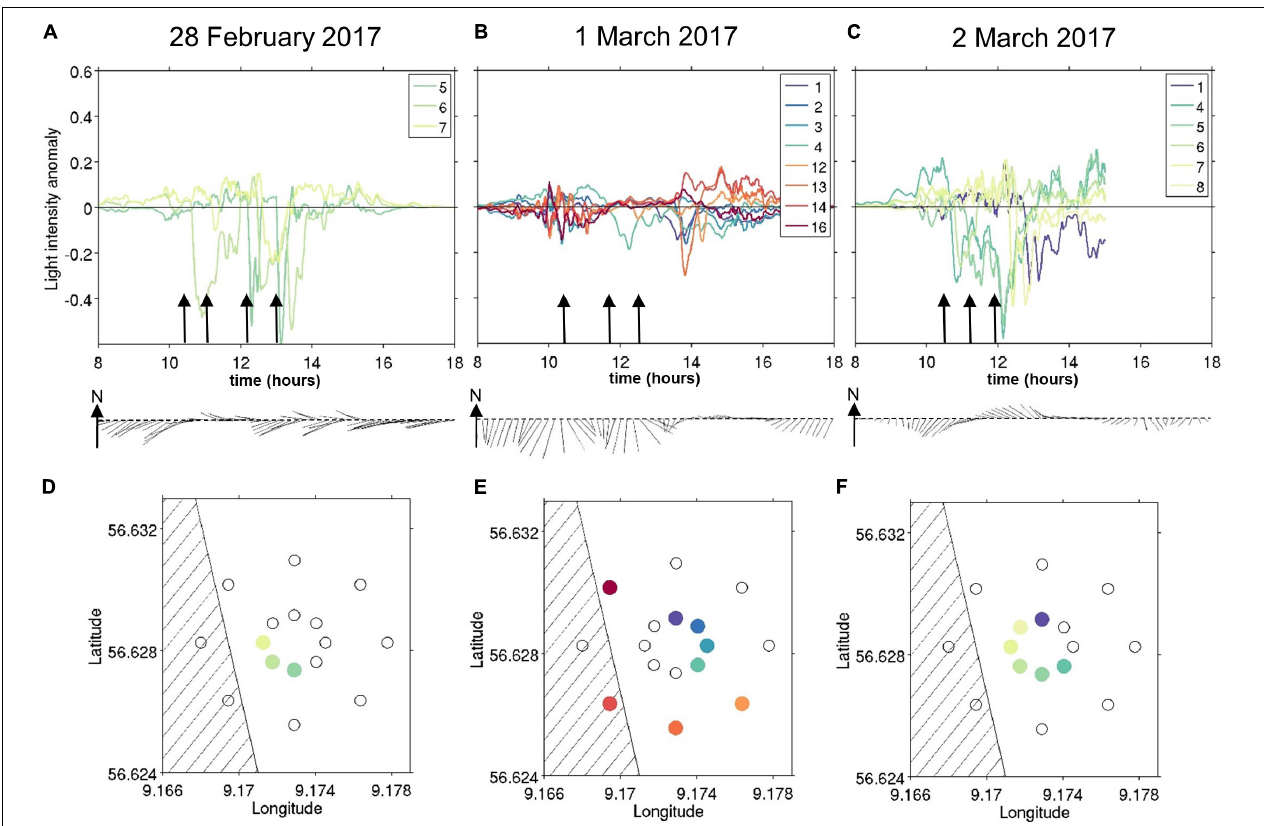
FIGURE 4 | Bottom-most (0.5 m) light intensity anomalies from normalized light intensity logger data at all moorings in Lovns Bredning. Time-series during different sampling days are shown in subfigures (A–C) with dredging periods indicated by black arrows. Mooring stations are numbered according to Figure 2A and have different colors. The stick plots below (A–C) display the dominant flow direction in the bottom-most depth layer (see Figure 3 for more information). Stick plots represent both flow magnitude and direction and are equally scaled. In subfigures (D–F) , the locations of moorings with detected light intensity anomalies are indicated using the same color code as in (A–C) for the respective days. The hatched area indicates the location of the eelgrass